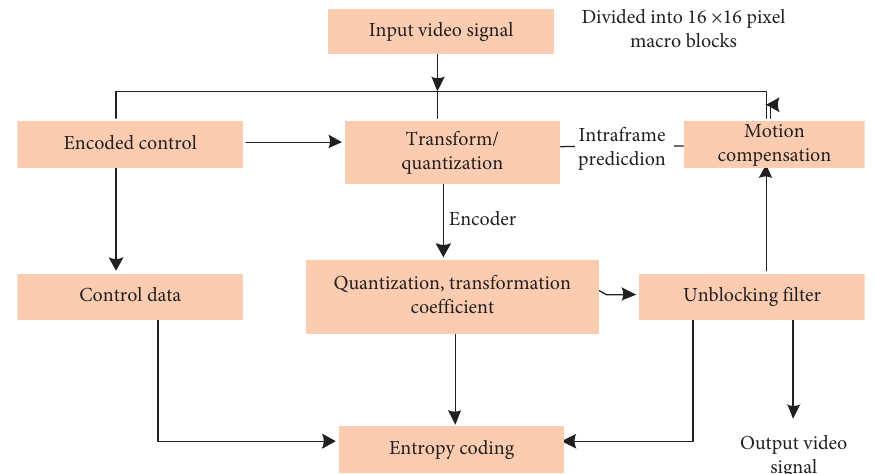
Figure 7: Block diagram of coding system of H.264 video coding layer.